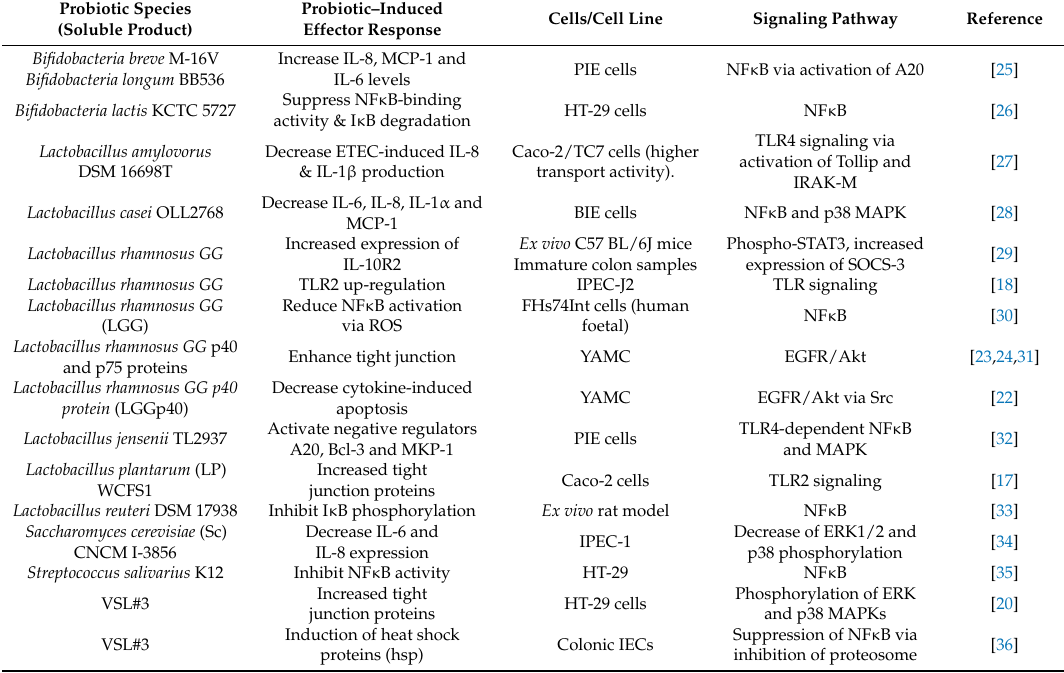
Table 1. Probiotic modulation of signaling pathways in intestinal epithelial